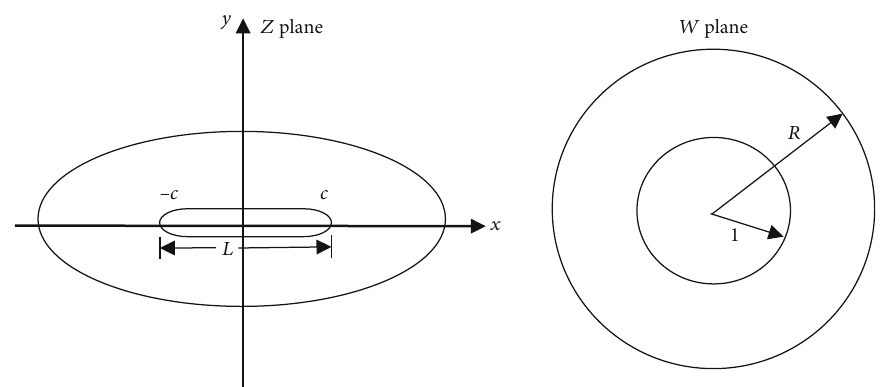
Figure 2: Conformal mapping of horizontal well with elliptic boundary.